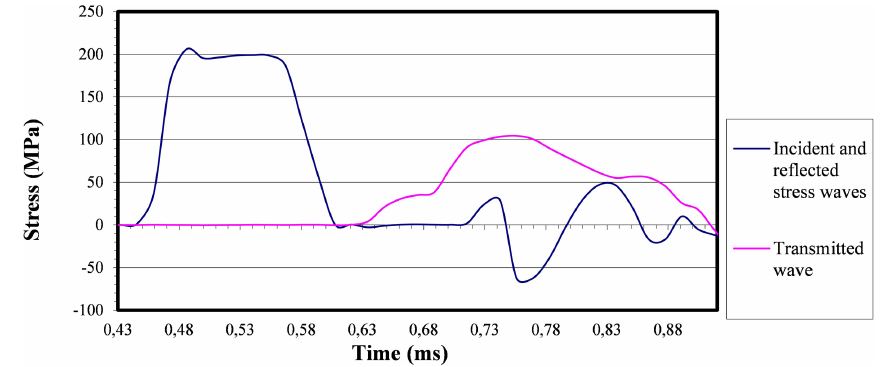
Figure 10. Incident and reflected stress-time curves in the centre of the SiC-reinforced ZC71 magnesium alloy specimen pertinent to the